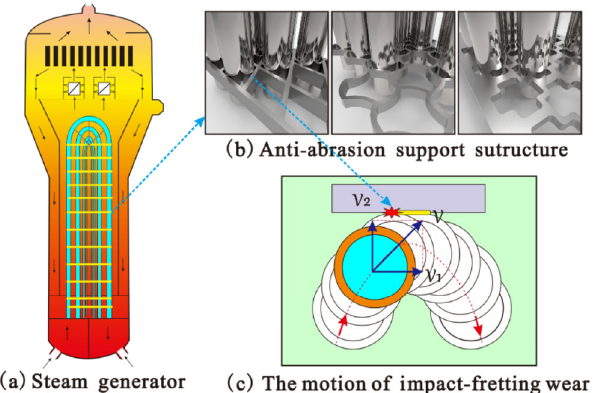
Fig. 1 Schematic of impact–sliding fretting